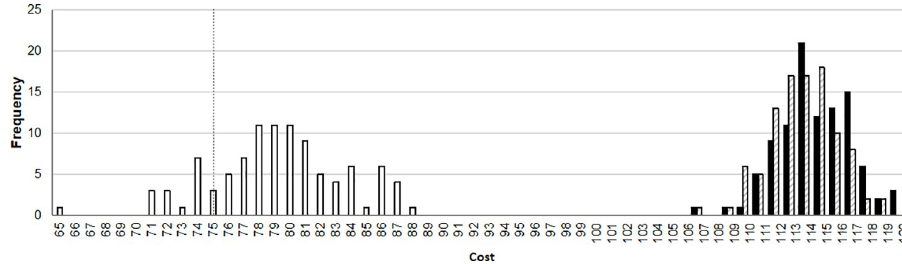
Fig 6. Distribution of costs of the reconstructions of the phylogenies. Null distribution of costs of the reconstructions of the independent phylogeny onto the dependent phylogeny using random tip mapping (RTM) and random parasite trees (RPT) for randomization are shown with slash pattern bars and black bars, respectively. Observed distribution of costs of the reconstruction of the bootstrapping-dependent phylogenies is shown with white bars. Observed cost (= 75) of the reconstruction of the consensus-independent phylogeny onto the consensus- dependent phylogeny is shown with a vertical dotted line.